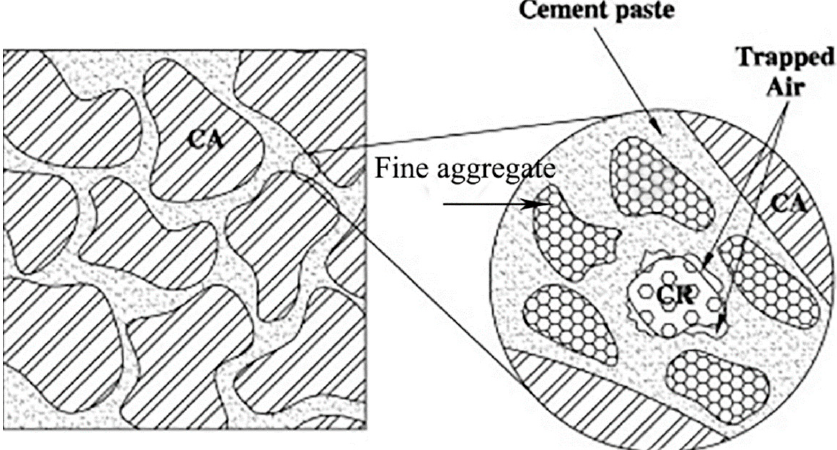
Figure 4. Microstructure of CR concrete [67].